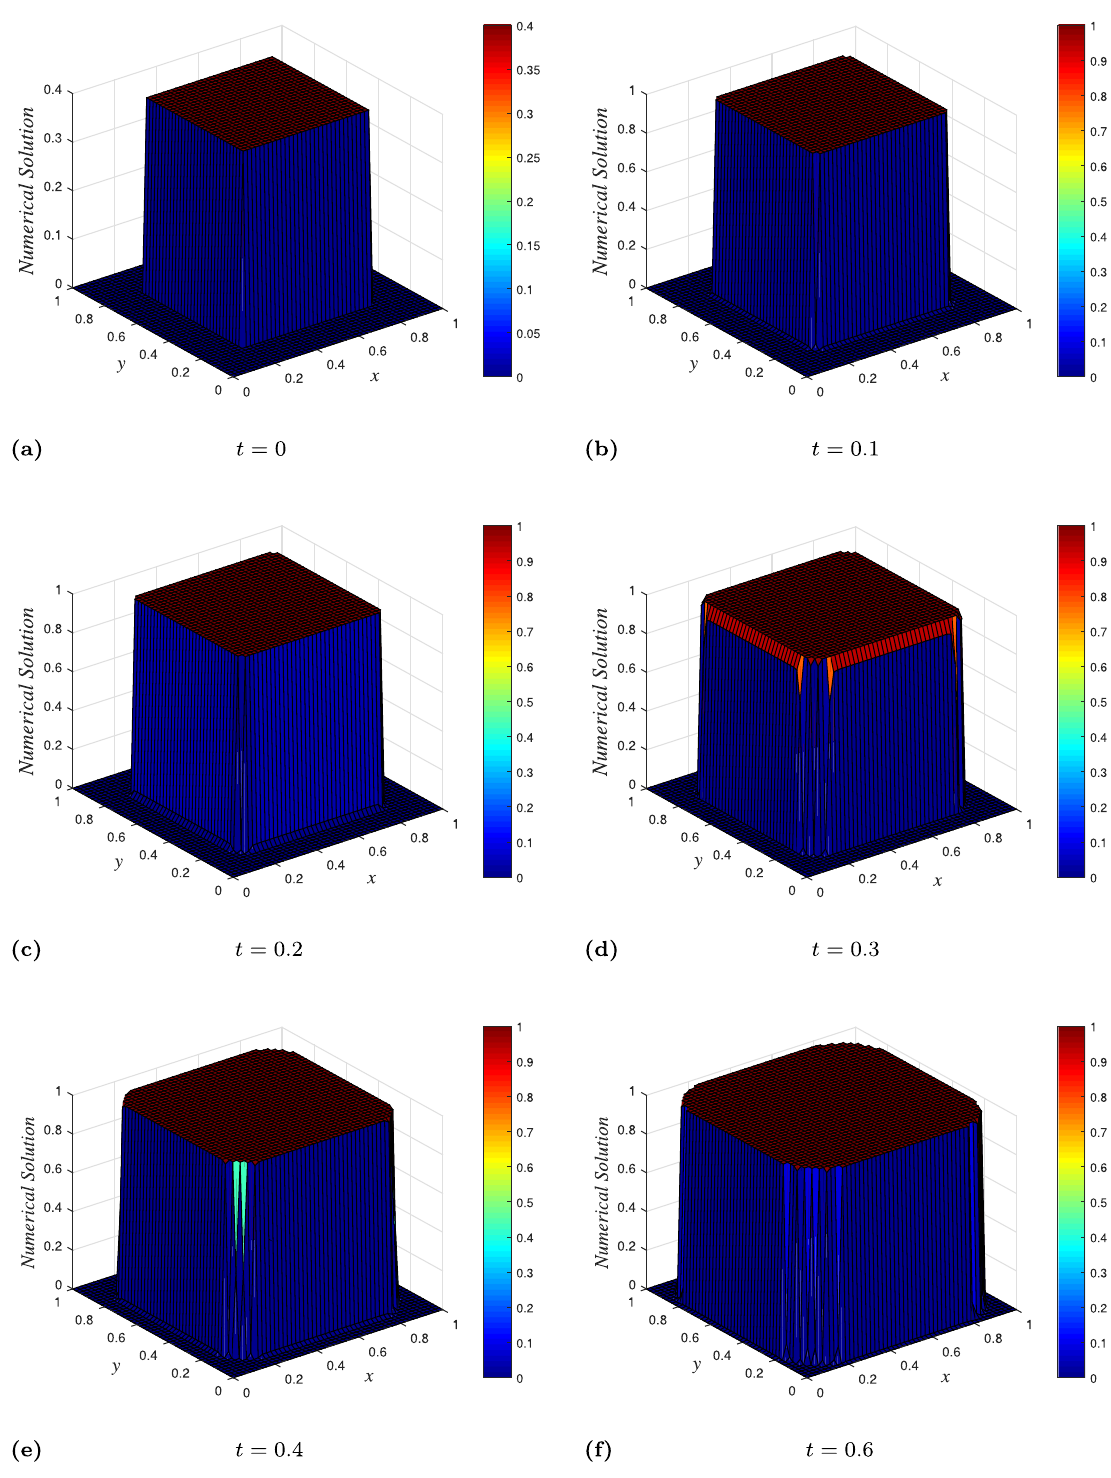
Figure 8: Plot of numerical solution vs x vs y using NSFD scheme at times = t 0, 0.1, 0.2, 0.3, 0.4 , and 0.6 with spatial step sizes = = h h 0.02 x y and time - step = k 0.0015 . ( a ) = t 0 . ( b ) = t 0.01 . ( c ) = t 0.02 . ( d ) = t 0.03 . ( e ) = t 0.4 . ( f ) = t 0.6